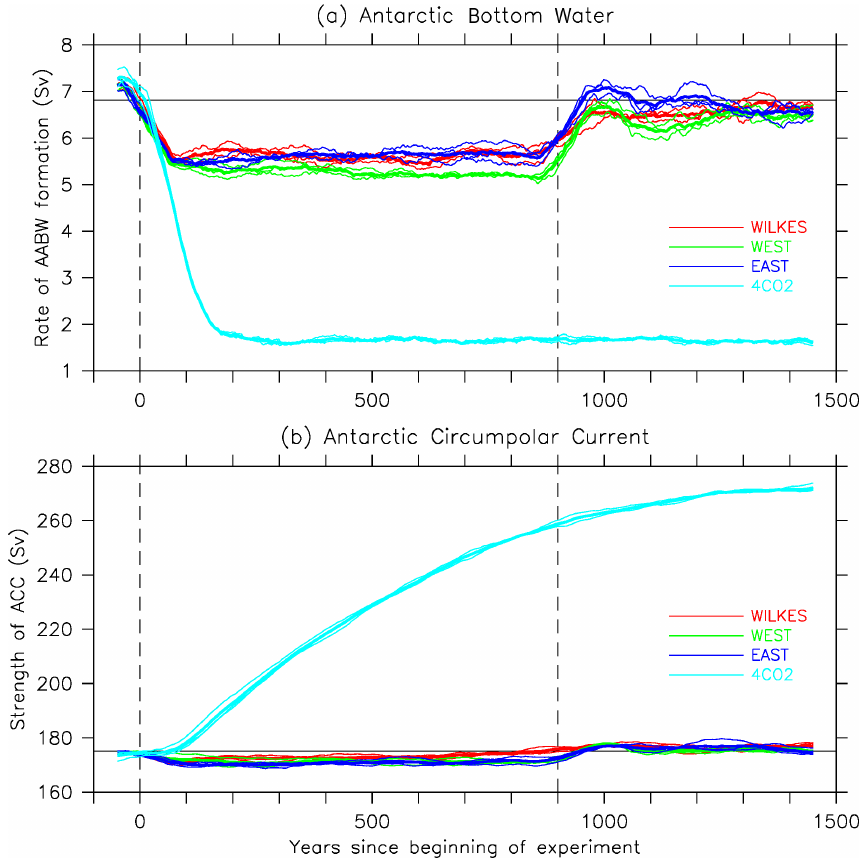
Figure 3. (a) The rate of Antarctic Bottom Water (AABW) formation (Sv), and (b) the strength of the Antarctic Circumpolar Current (ACC) (Sv), in experiments WILKES (red), WEST (green), EAST (dark blue) and 4CO2 (light blue). Thin lines indicate individual ensemble members; thick lines indicate the ensemble means. The values shown are 100-year running averages. Solid horizontal lines indicate the mean values for the control simulation. Dashed vertical lines indicate the years in which the freshwater hosing begins and